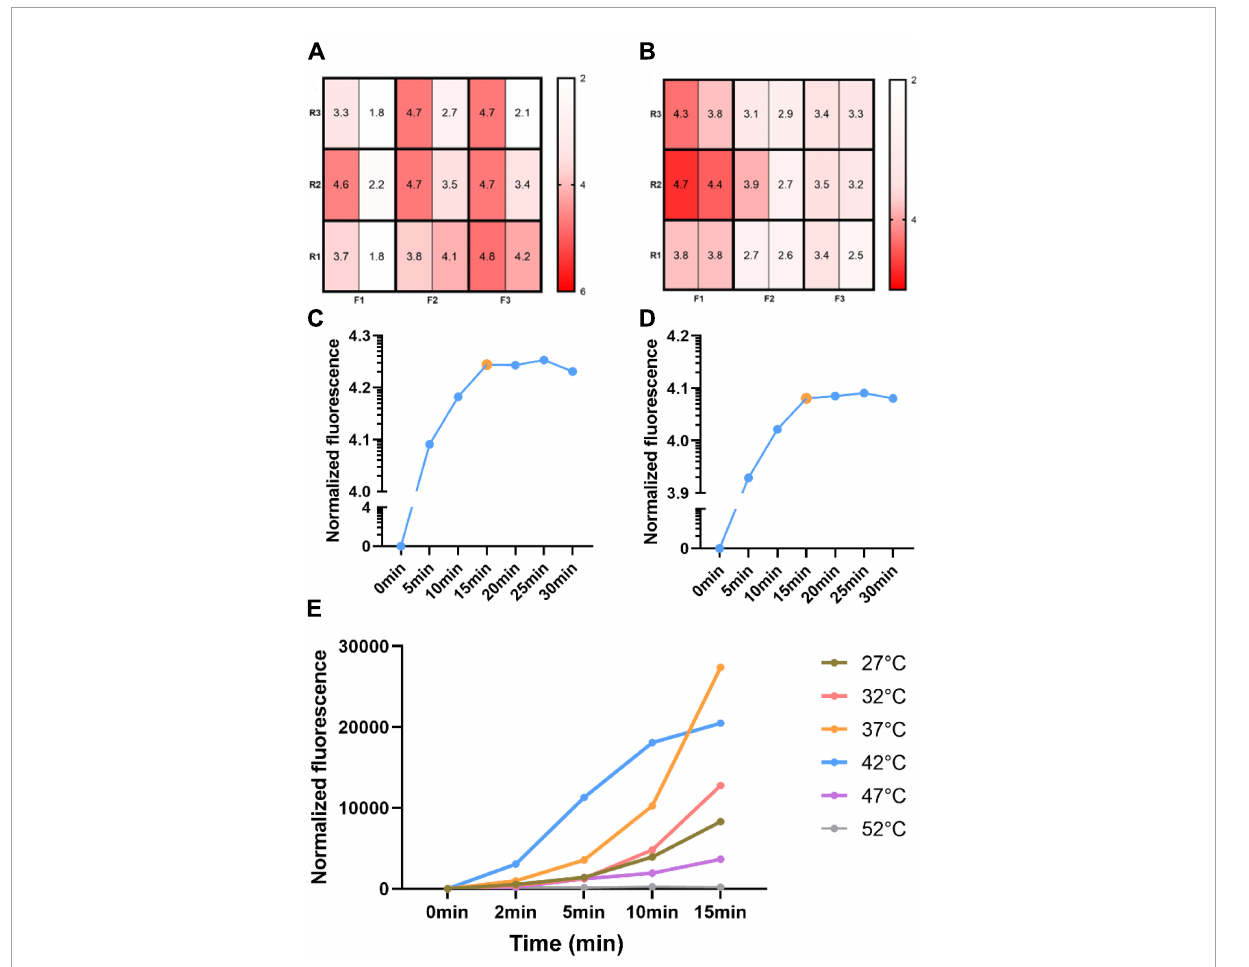
FIGURE3 Development and optimization of the reaction system. Heat maps of RPA primer screening of ORF1ab gene (A) and N gene (B) . The abscissa represents three pairs of forward primers and the ordinate represents three pairs of reverse primers. In each box, the left side represents the result under the high concentration template and the right side represents the result under the low concentration template. A time-dependent curve of the RPA reaction (C) . The orange dot represents the time of the arrival of the platform stage. A time-dependent curve of the CRISPR reaction (D) . The time-dependent curves of the reaction under different temperatures (E)